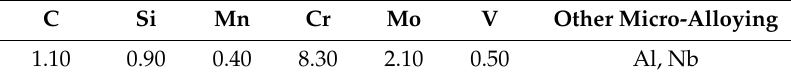
Figure 4. Characteristic elements of the tool and material arrangement: ( a ) Outline of the die hole and punch; ( b ) clearance ( C ) and blanking depth ( H ) of the punch in the sheet. Table 3. Chemical composition of the cold-work tool steel K340 (in weight percent).